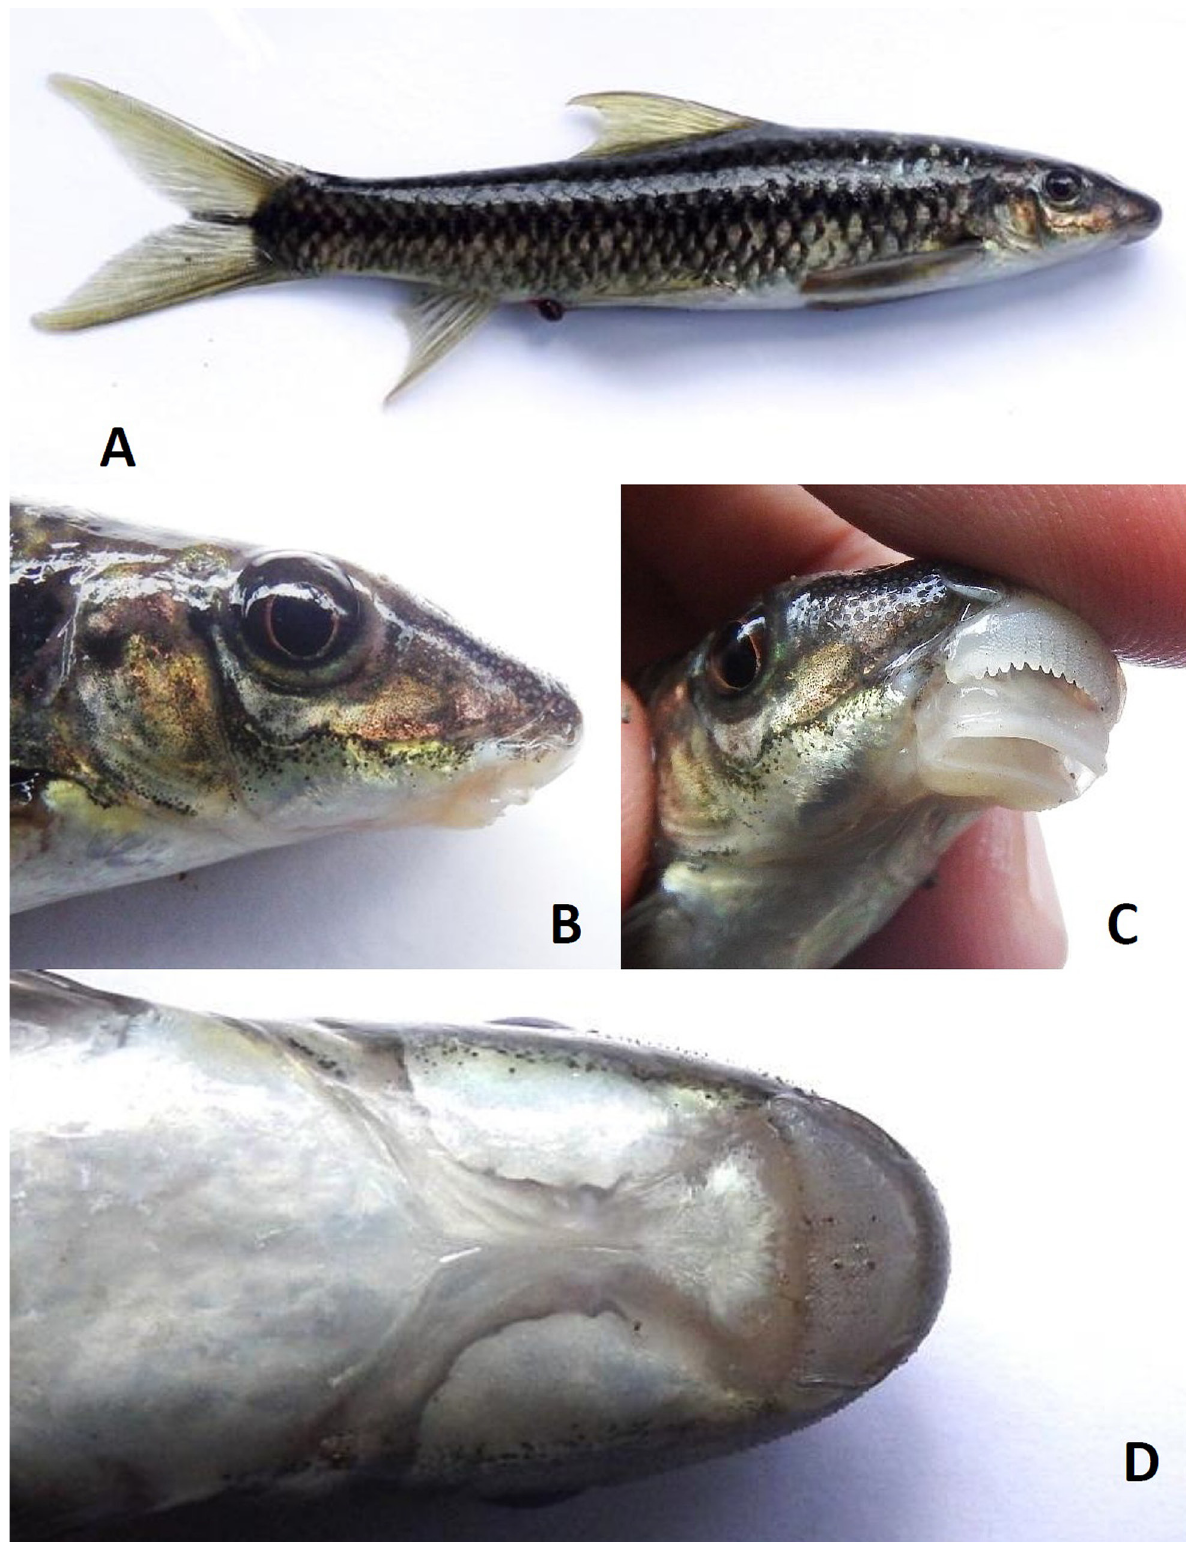
Figure 3. Crossocheilus obscurus (13 cm TL), Musi basin, Muara Kulam River, South Sumatra: A. lateral view. B. lateral view of head. C. detail of mouth showing upper lip with few fimbriaes. D. ventral view of head . Photographs by M.